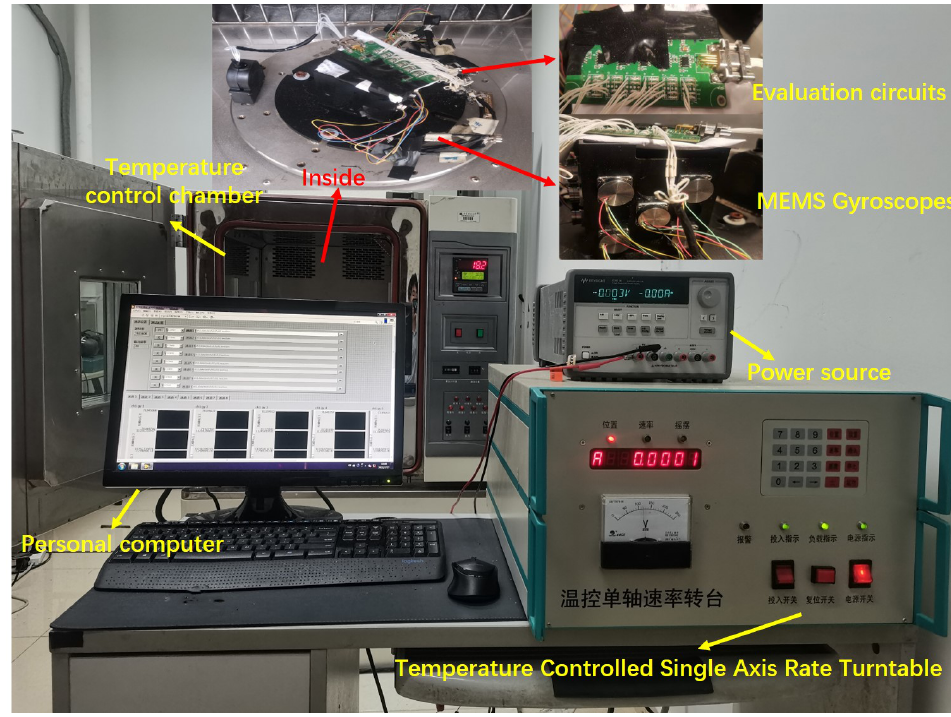
Figure 4. Experiment